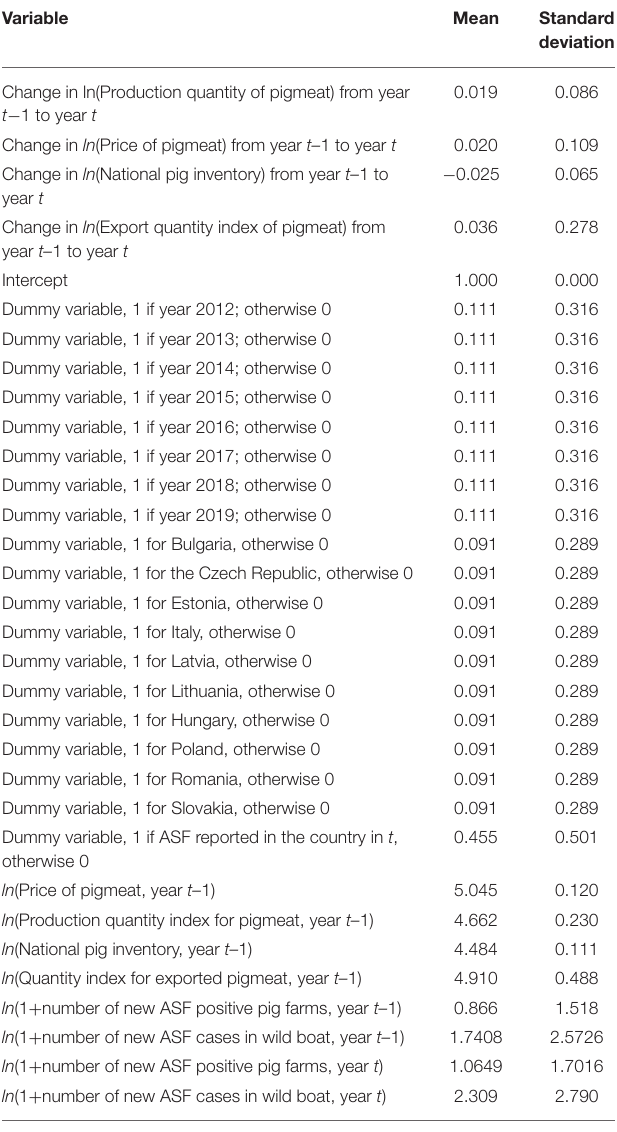
TABLE 2 | Mean and standard deviation of parameters used in the seemingly unrelated regression equations estimation. Variable Mean Standard